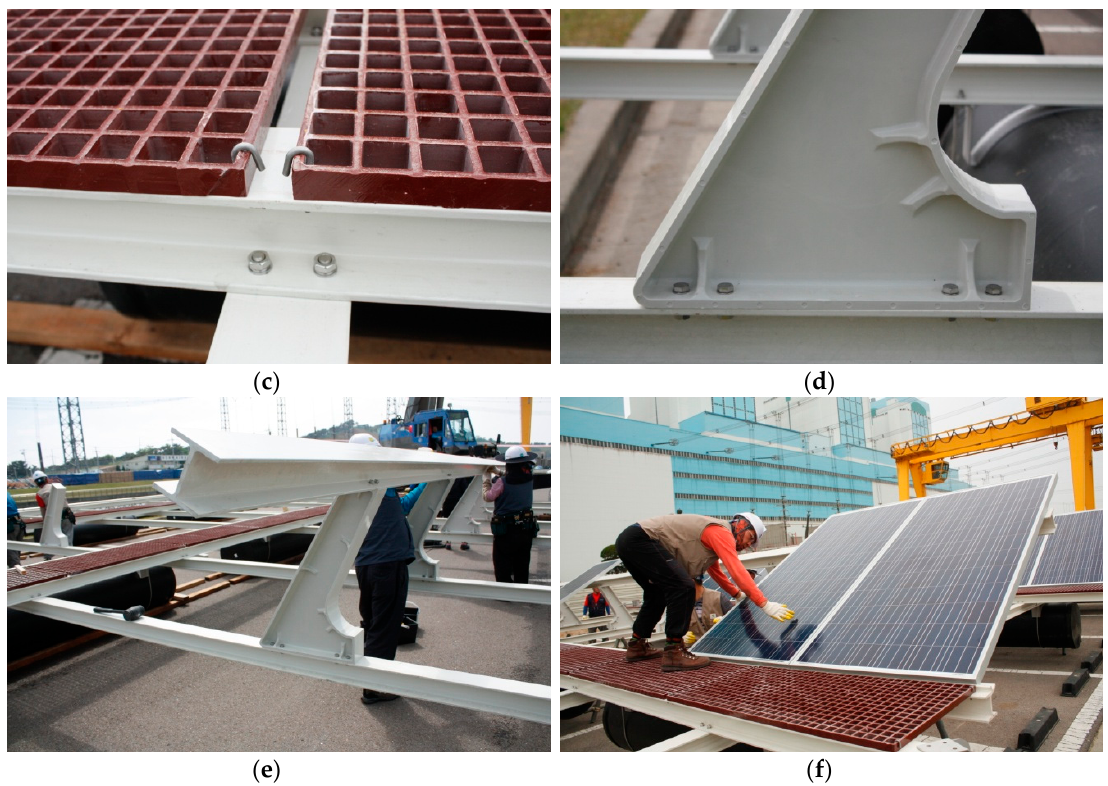
Figure 12. Fabrication process; ( a ) Fabricating plane frame; ( b ) Assembling buoy; ( c ) Assembling foothold; ( d ) Assembling SMC FRP member; ( e ) Assembling module support frame; ( f ) Assembling solar module.